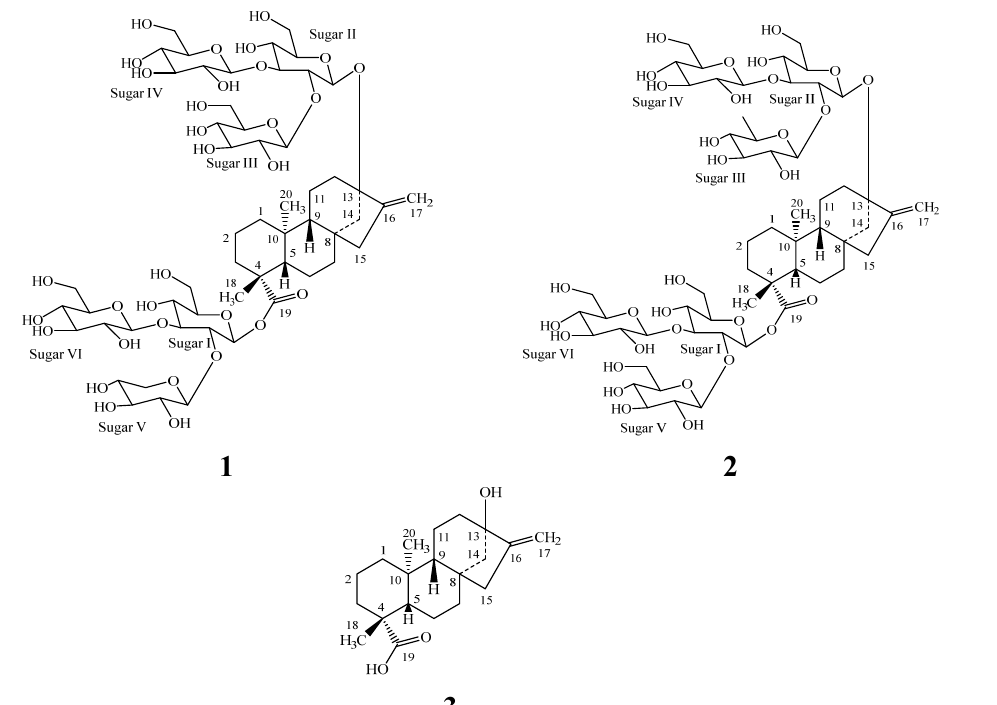
Figure 1. Structures of 1 , 2 and steviol ( 3